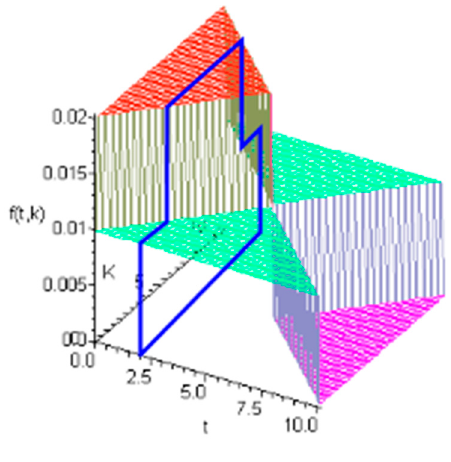
Figure 2. PDF for a semi-random trip. Figure 3. Joint PDF. Figure 3. Joint